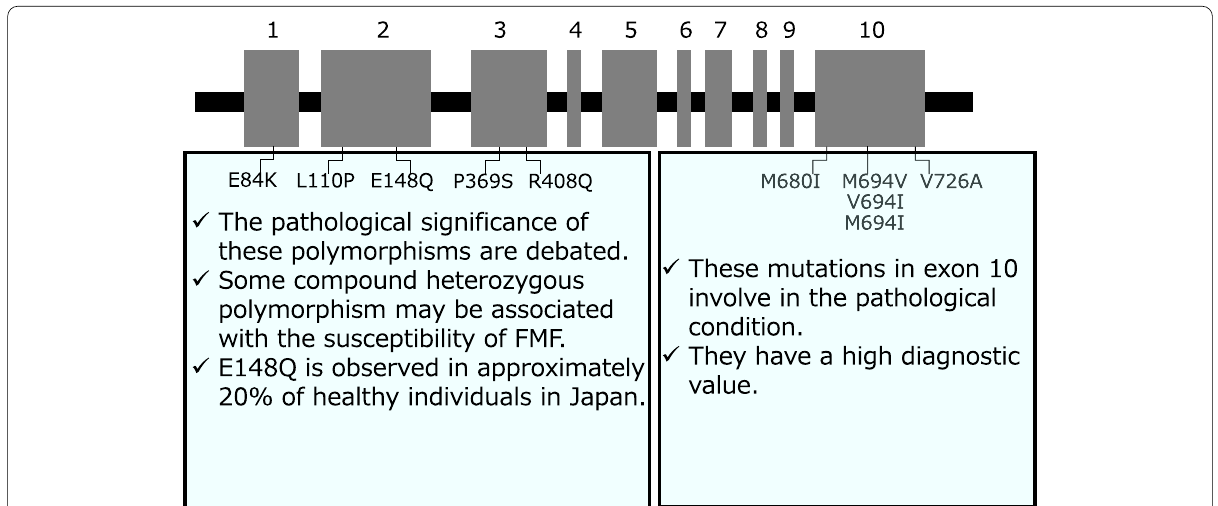
Fig. 1 A domain structure of the MEFV gene. The MEFV gene is composed of 10 exons. The figure shows representative mutations and variants of the MEFV gene; however, according to the INFEVERS database (https://infevers. umai‑ montp ellier. fr/ web/), there are 389 sequence alterations that have been reported as of May 12,